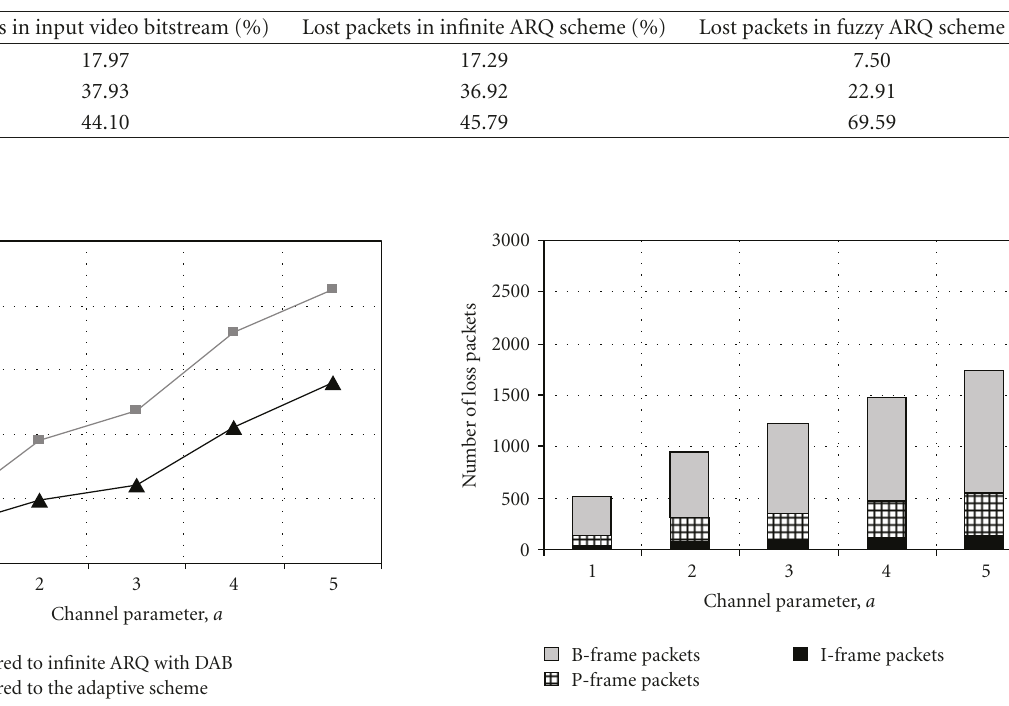
Figure 14: Relative power saving of the FLC power-aware ARQ scheme compared to that of the default ARQ and the adaptive ARQ [34] schemes.